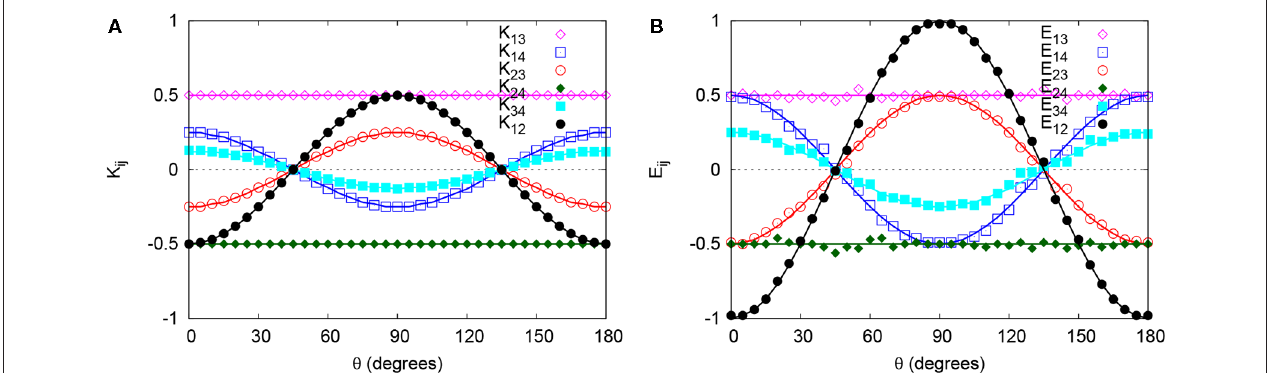
FIGURE 2 | DES results for the correlations between all pairs of the S -variables as a function of θ pairs of photons with orthogonal polarizations chosen randomly. Ignoring statistical fluctuations, the averages of all S -variables (not shown) are zero. (A) The correlations K ij computed without photon identification (markers) are in excellent agreement with the corresponding correlations Maxwell’s theory (solid lines) for two light beams with orthogonal, random polarization ( φ 0 (markers) are in excellent agreement with the corresponding correlations singlet state.